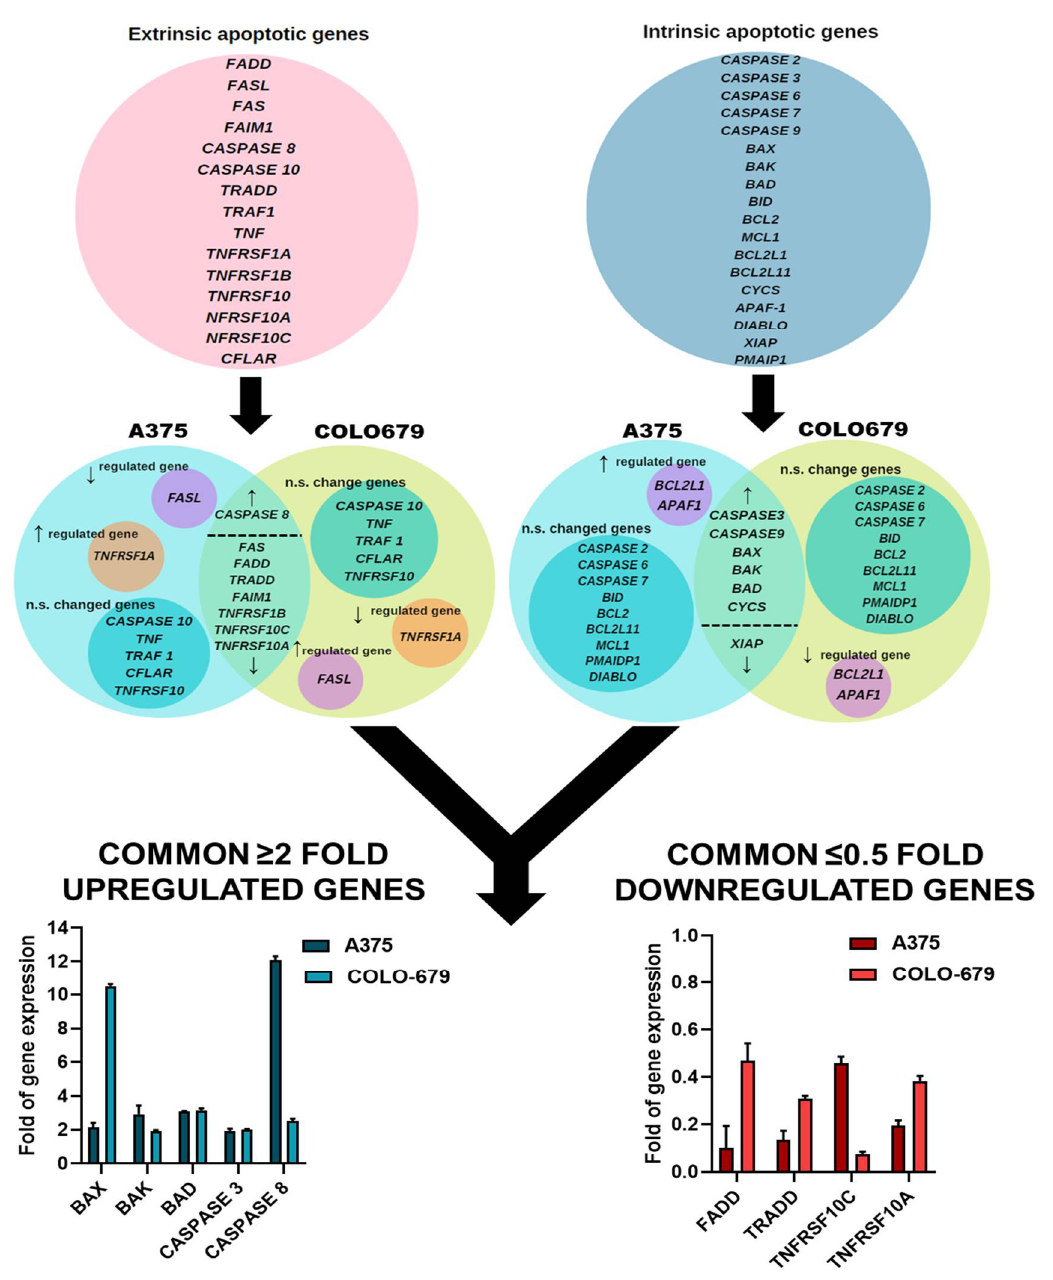
Figure 3. Panels of extrinsic and intrinsic apoptotic genes are shown in separate circles (red and blue, respectively). For each cell line, there are different circles indicative of genes being up- or down-regulated or remaining non-significantly (n.s.) changed. Light green panels indicate extrinsic or intrinsic apoptotic genes being common to both cell lines and either being up- or down-regulated. Finally, genes being up- or down-regulated by at least 2-fold or 0.5-fold, respectively (in either of the two cell lines), are also presented. Table 4. Gene expression profiling of various intrinsic and extrinsic apoptotic genes in A375 and COLO-679 cell lines.